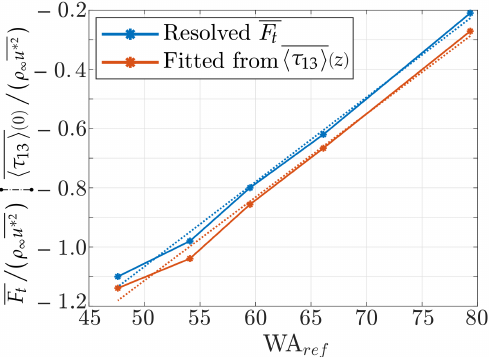
Figure 13. Normalized total drag as a function of the reference WA ref . Comparison between the resolved value, and the one extrapolated from the linear fitting depicted in Figure 12. Here, a linear fitting applies to F t ( WA ref ) , and is shown with dotted lines in the figure. The fitting coefficients are given in Table